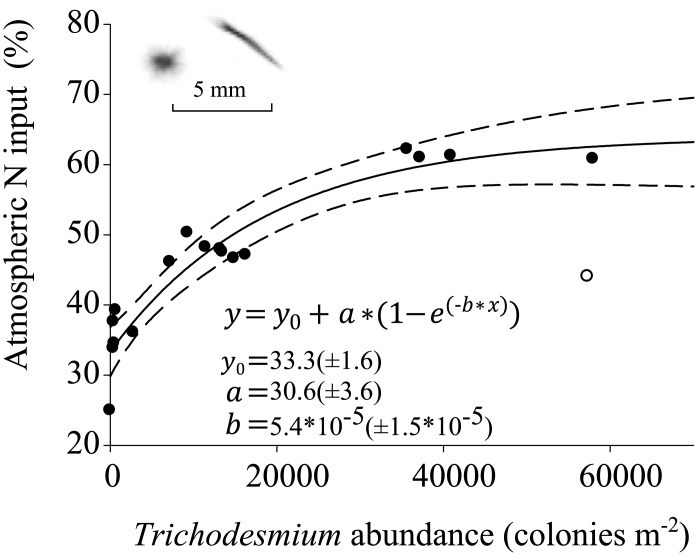
Contribution of calculated atmospheric N input (%) to zooplankton biomass as a function of integrated Trichodesmium abundance (colonies m-2).The station at 18°N, 19°41’W within the eddy (denoted with an empty circle) was excluded from the analysis. The inset shows UVP5 example images of Trichodesmium puff and tuft, respectively.